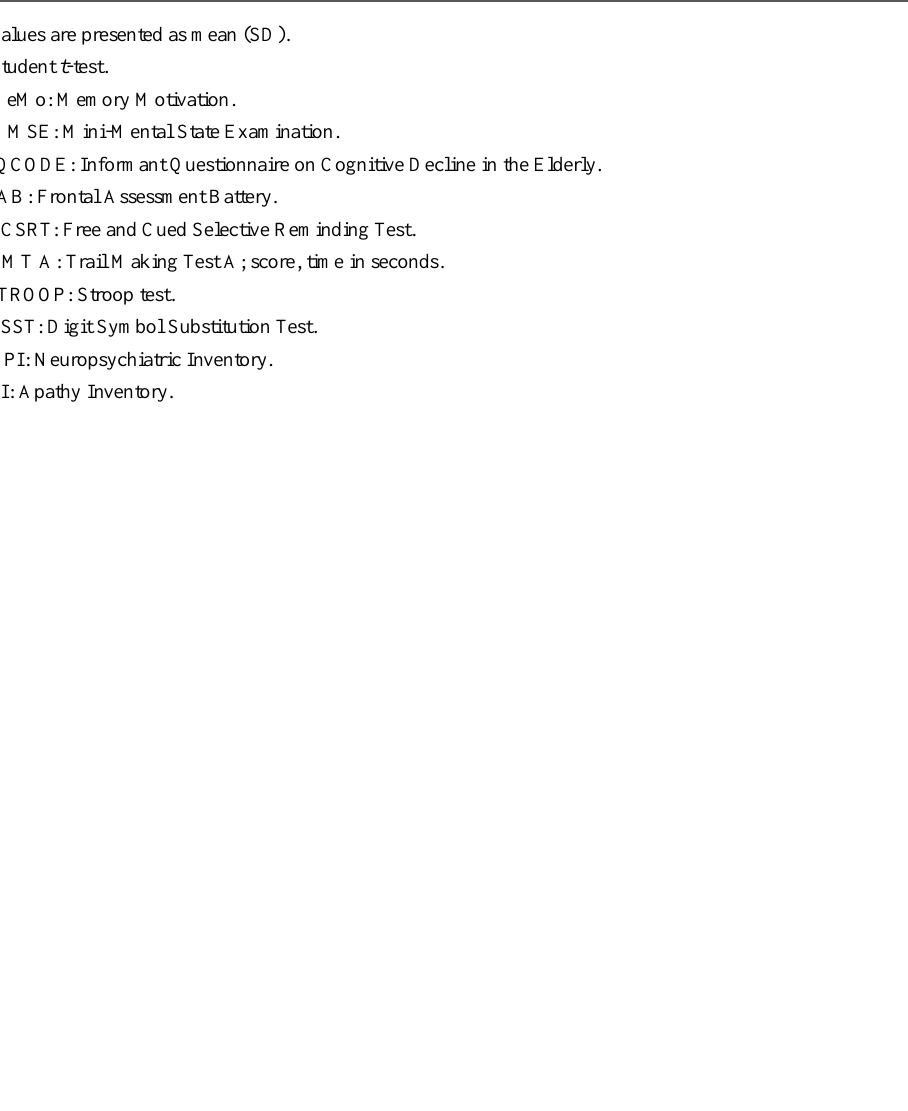
P value b Score difference a